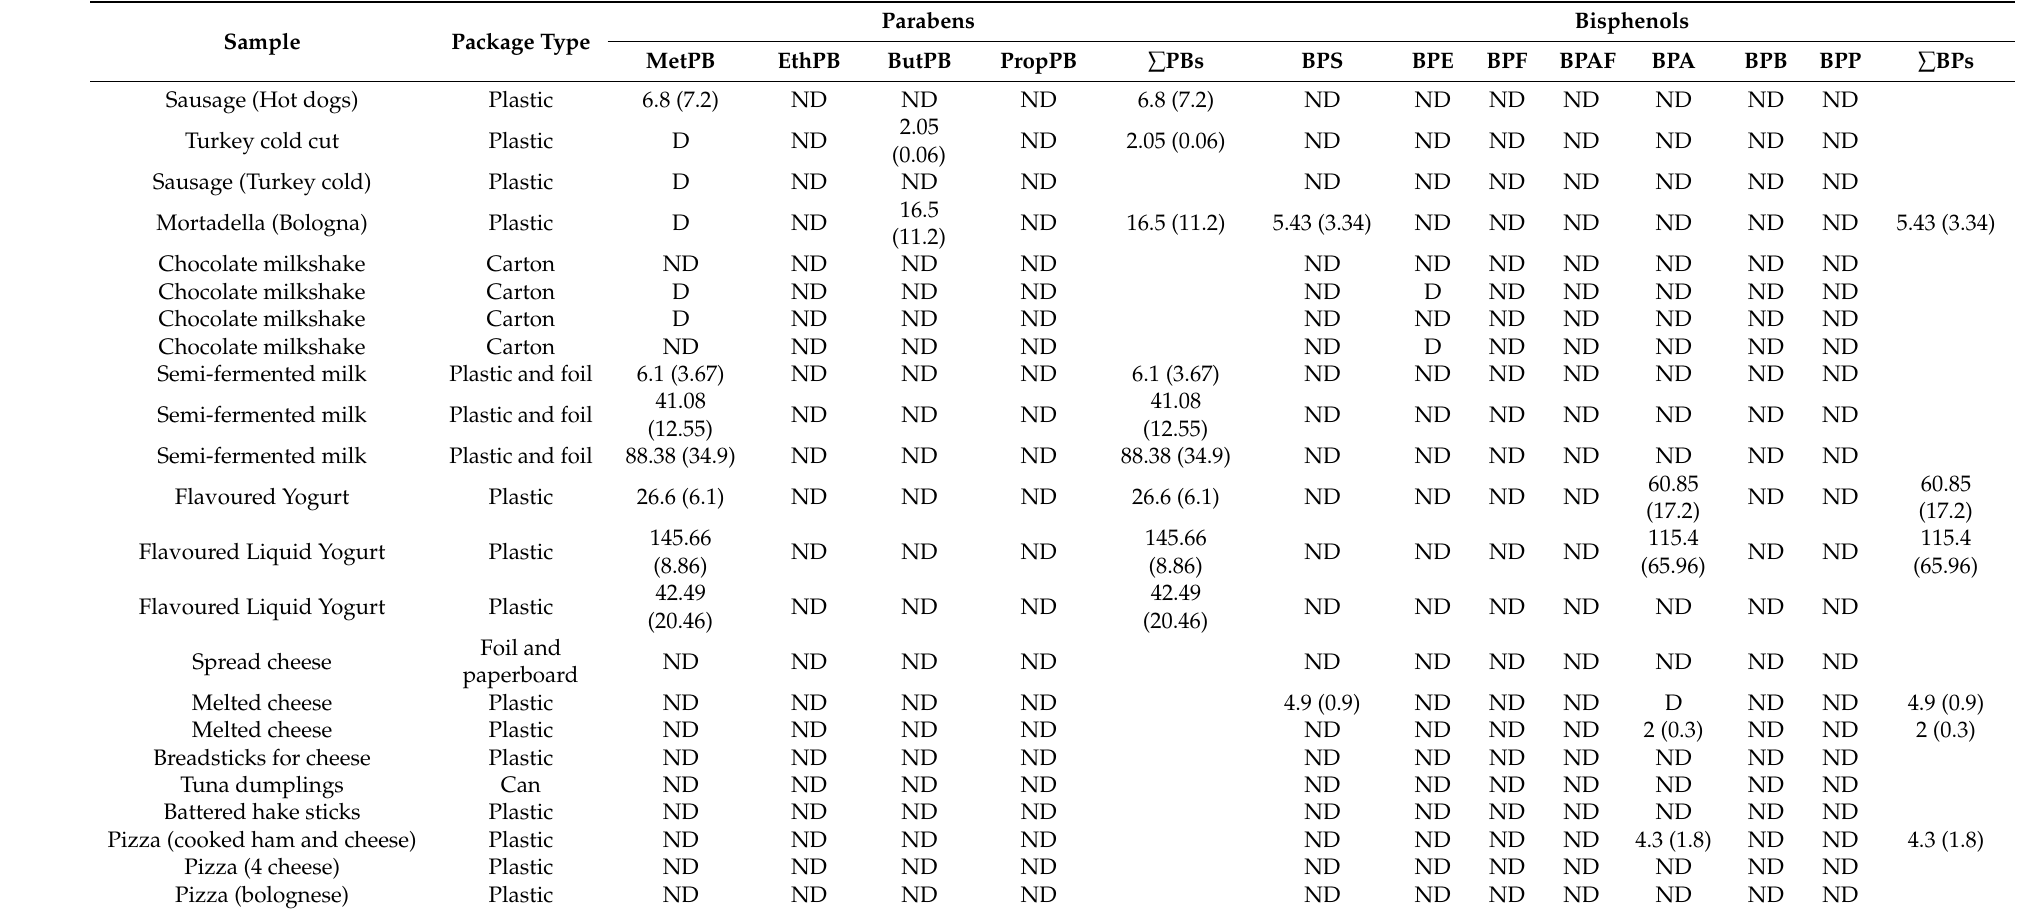
Table 6. Concentrations (ng g − 1 dw) of parabens and bisphenol analogues in ultra-processed